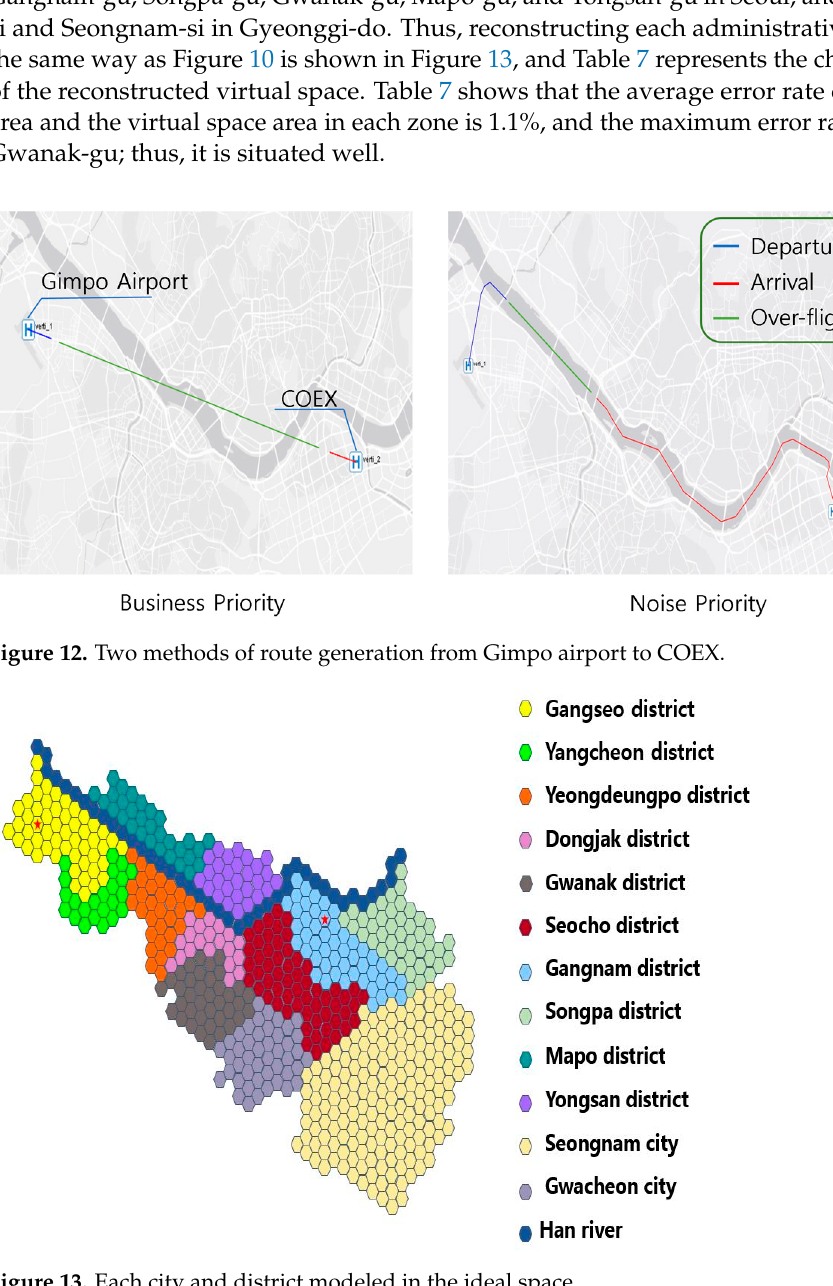
Figure 13. Each city and district modeled in the ideal space.